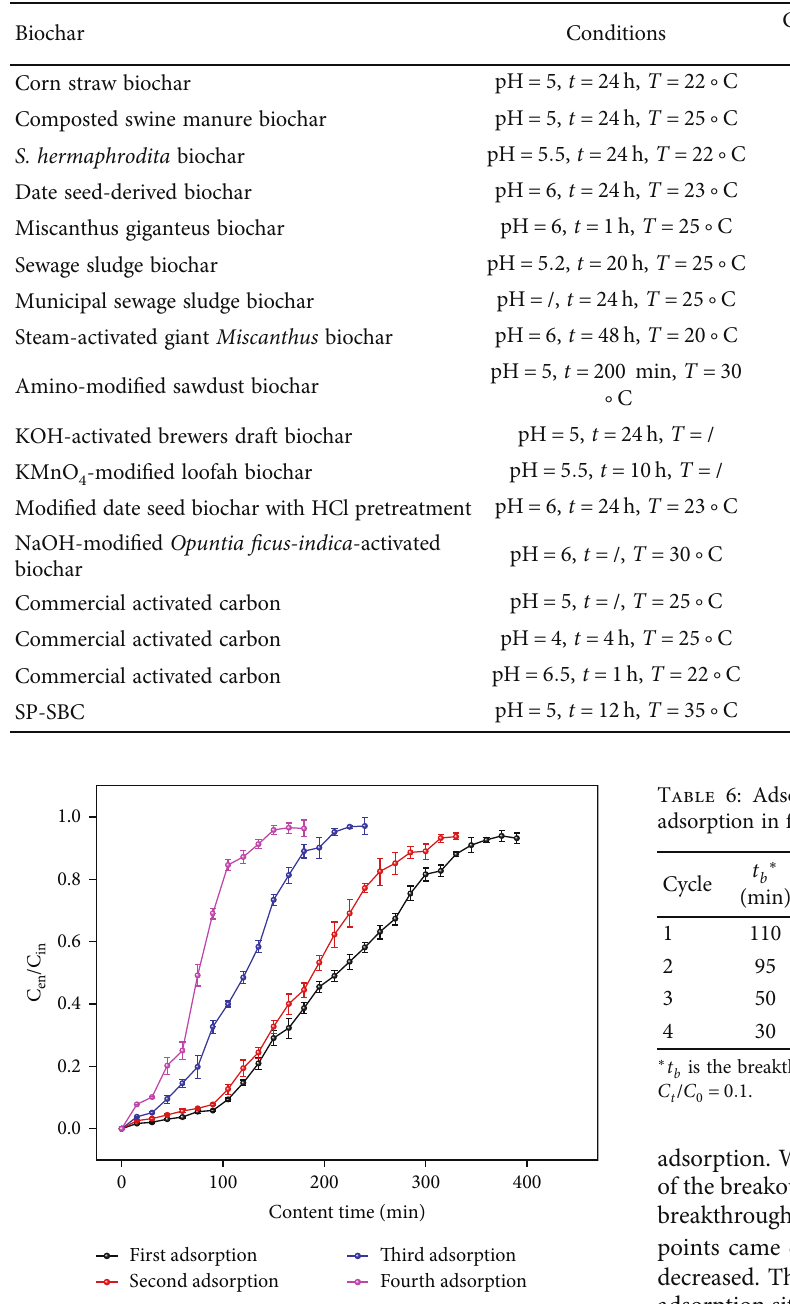
Figure 12: Breakthrough curves of four adsorption – desorption cycles in the fi xed-bed column experiment.